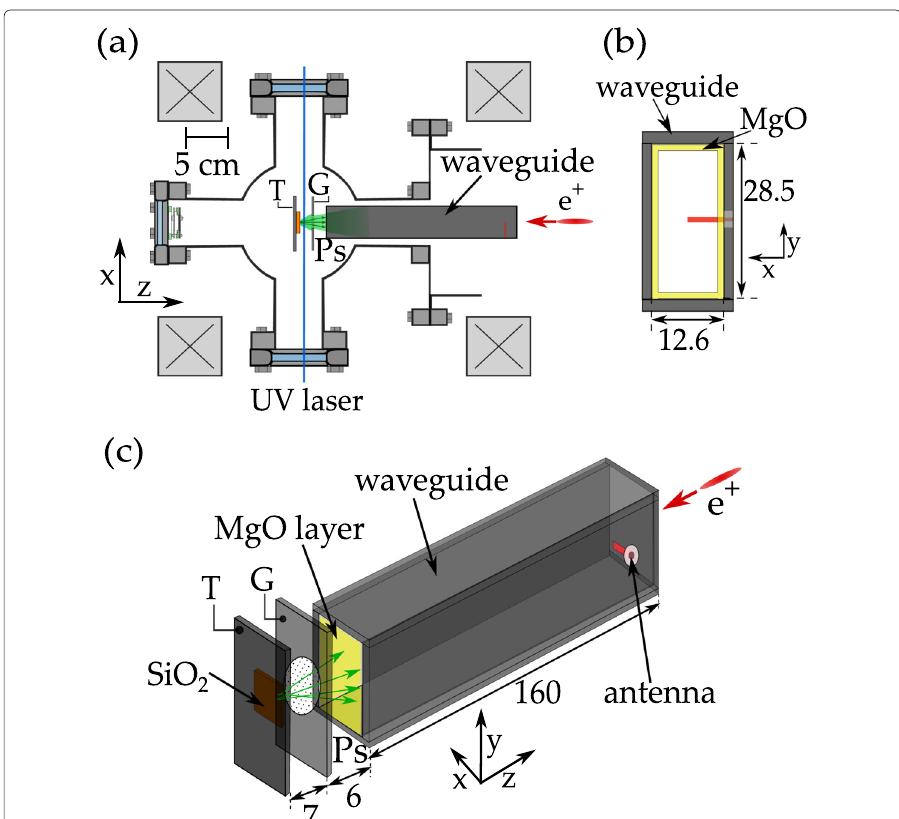
Fig. 1 a A schematic of the Ps production region, detectors, and waveguide. b A cross-section of the MgO coated WR-112 waveguide in the xy plane. c A 3-D schematic of the target, grid, and microwave guide. The target (T) and grid (G) electrodes were mounted on a separate manipulator that could be moved off axis to allow direct imaging of the positron beam after it had passed through the waveguide.The waveguide dimensions are in